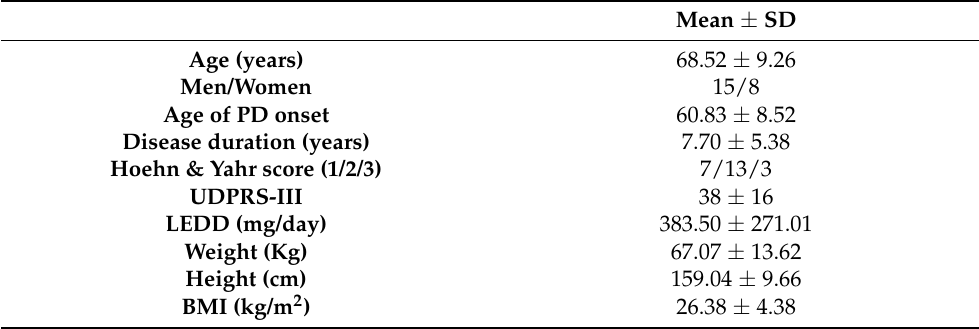
Table 1. Demographic and clinical characteristics of patients with Parkinson’s disease.